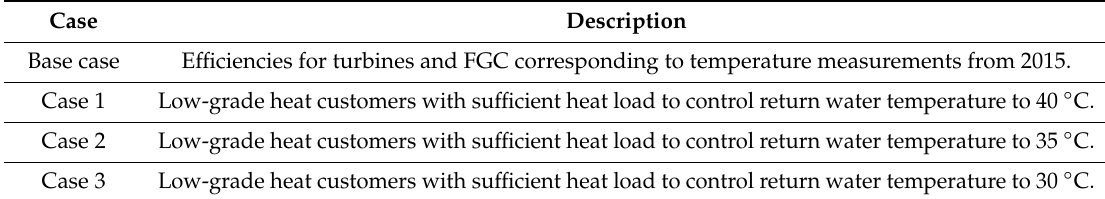
Table 5. Description of the studied